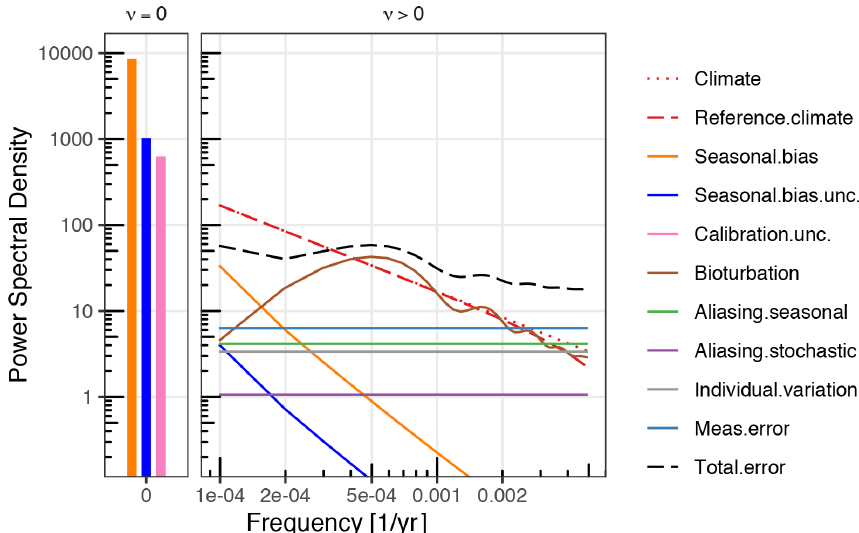
Figure 4. Power spectra of error components of a climate proxy record. As the proxy record was sampled at 100-year resolution, only the power-law portion of the climate power spectrum is visible. The error spectra are plotted on log–log axes with a broken frequency axis so that power at the zeroth frequency ( ν = 0) can be shown.